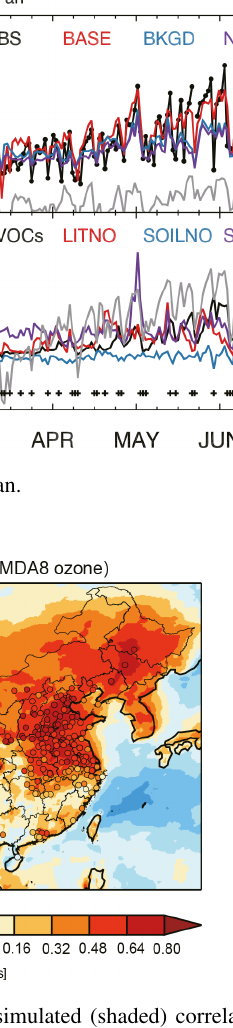
Figure 10. Observed (circles) and simulated (shaded) correlation coefficients between deseasonalized surface daily MDA8 values and maximum 2m air temperature (TMAX) for May–August 2016–